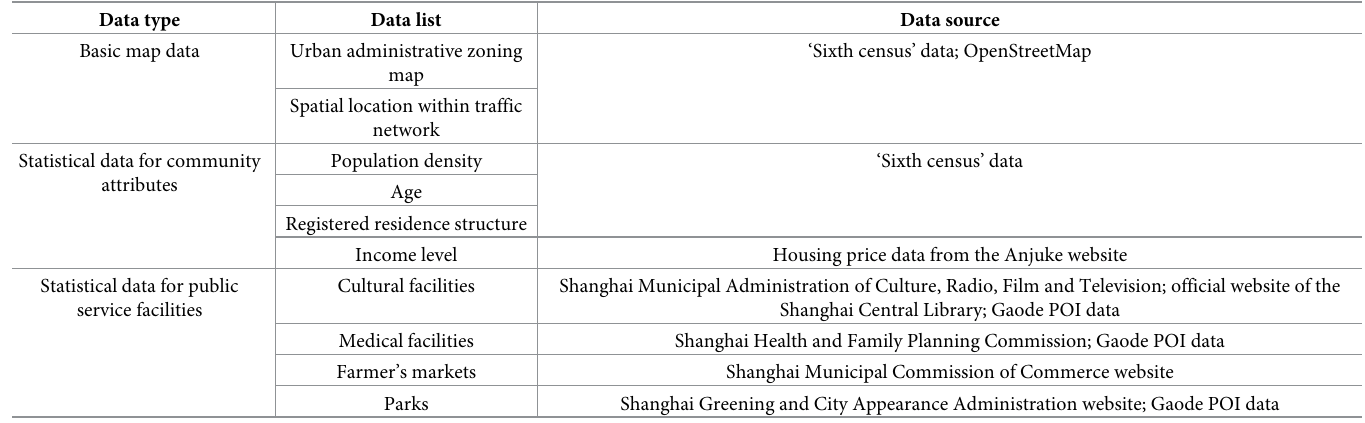
Table 1. Data list with